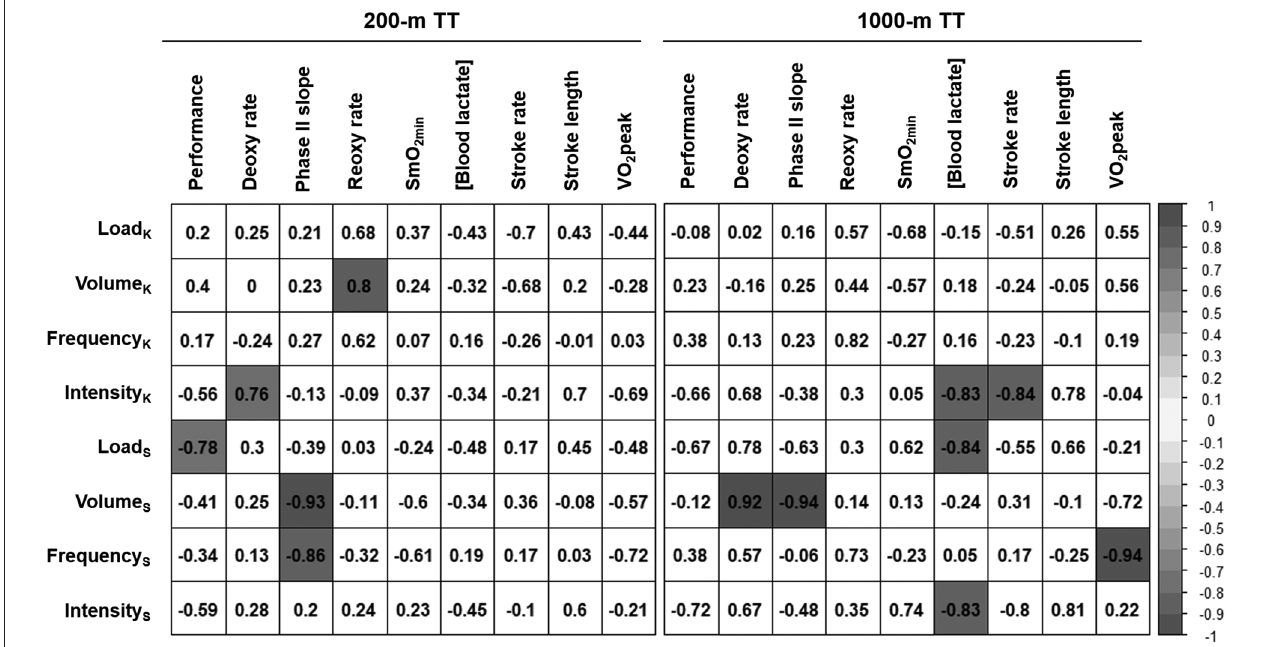
FIGURE 5 | Association between training load during the 3-weeks training camp and changes in performance, physiological and stroke parameters during the 200-m and 1,000-m TT between pre- and post-training time trials. Load K : Kayak training load (AU/week), Volume K : Kayak training volume (h/week), Frequency K : Frequency of kayak sessions (sessions/week), Intensity K : average intensity (average RPE) of kayak sessions, Load S : Strength training load (AU/week), Volume S : Strength training volume (h/week), Frequency S : Frequency of strength training sessions (sessions/week), Intensity S : average intensity (average RPE) of strength training sessions, [Blood lactate]: blood lactate concentration at 3-min post-race. Values are Pearson’s correlation coefficients, and colored values represent p <